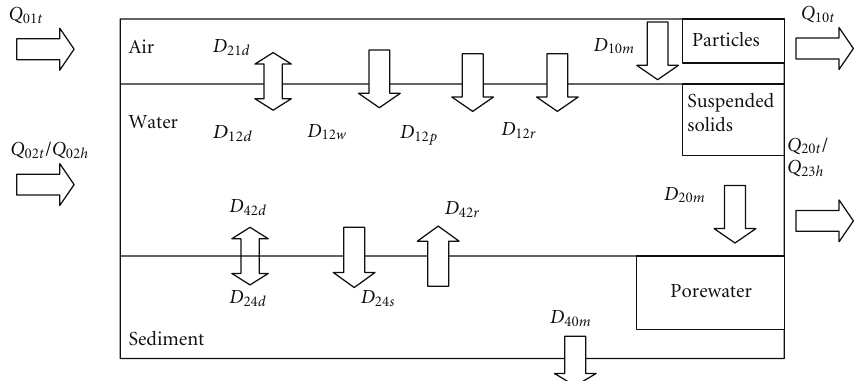
Figure 1: Transport fluxes of α -HCH in and out of the Lake Chaohu area and between the adjacent compartments. D 12 d , D 21 d , D 24 d , and D 42 d represent the di ff usion processes between air/water and water/sediment. D 12 p and D 12 w represent the dry and wet deposition from air to water, respectively. D 12 r represents scavenging by precipitation. Q 01 t , Q 02 t , and Q 02 h represent the input from air advection, water inflows, and waste water discharge, respectively. Q 10 t , Q 20 t , and Q 23 h represent the output from air advection, water outflows and water reuse by industry, and agriculture, respectively. D